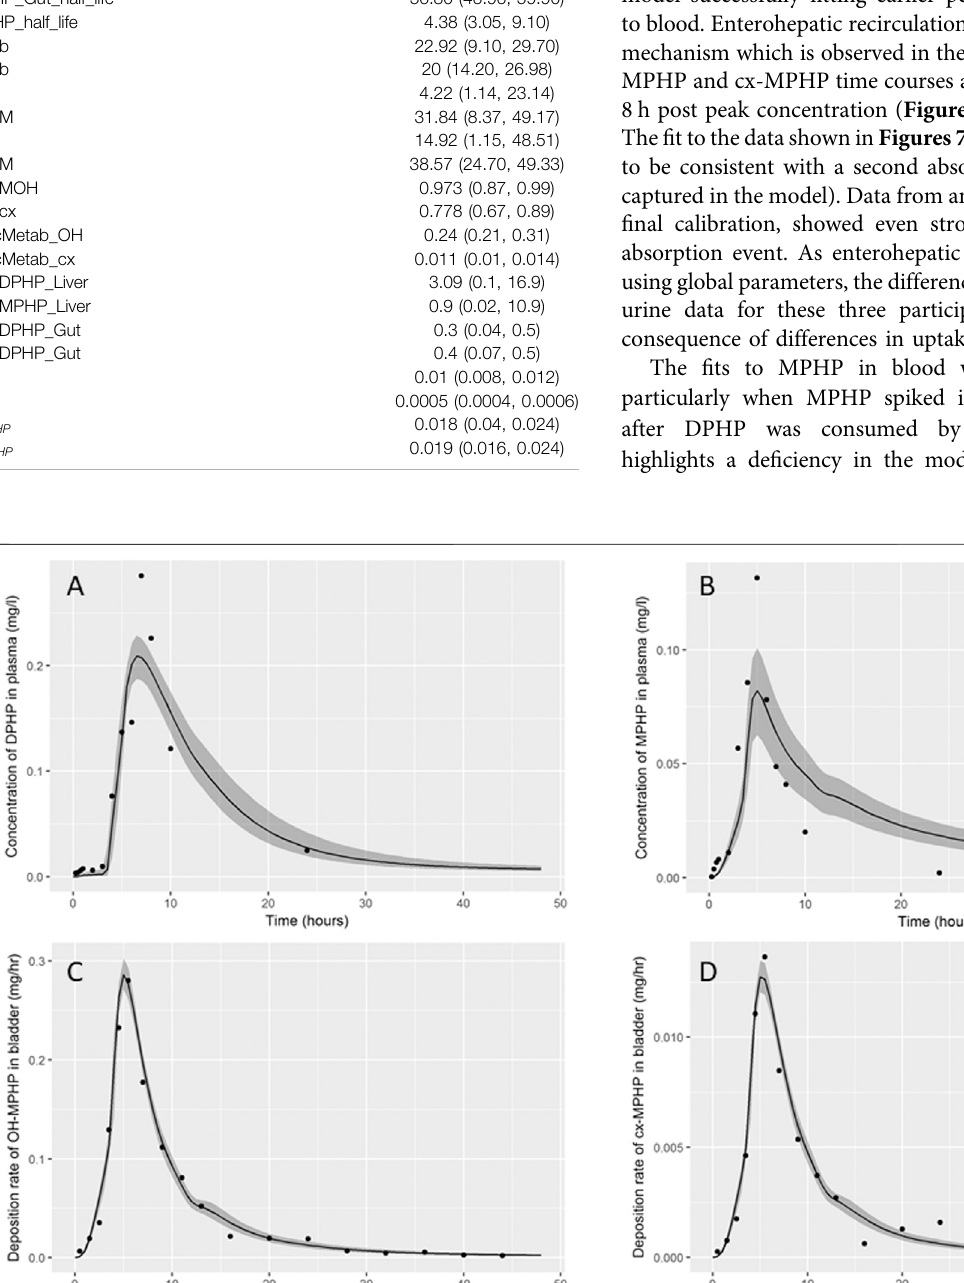
Frontiers in Pharmacology |